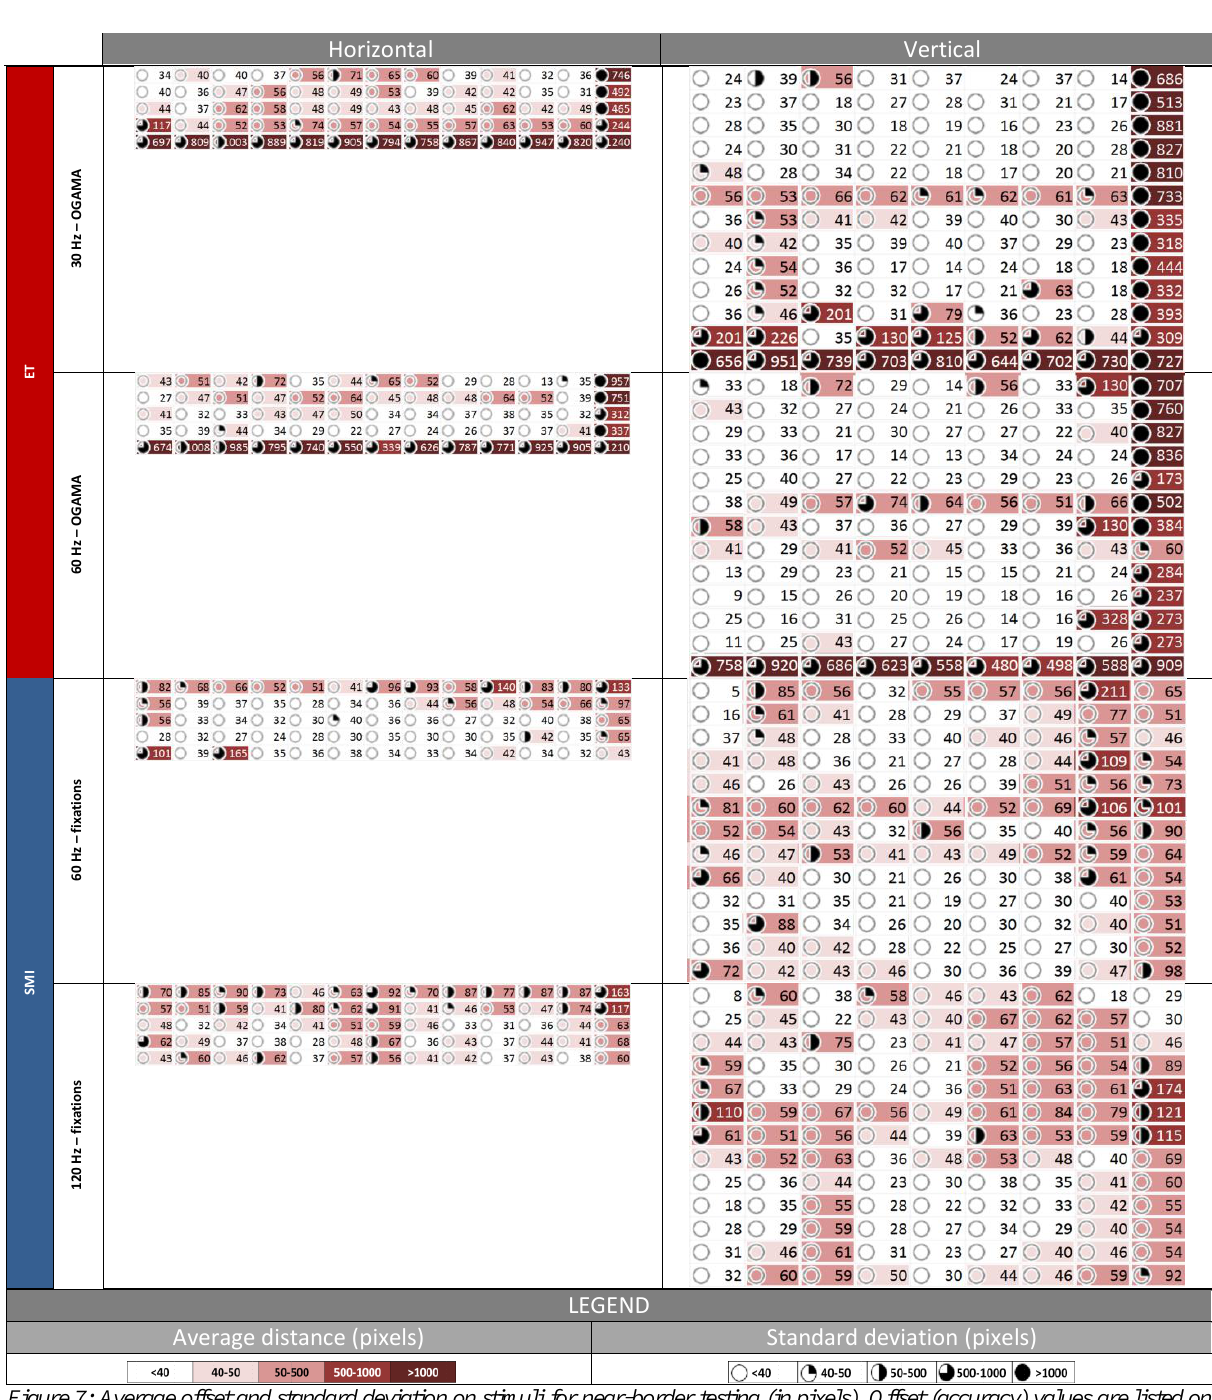
Figure 7: Average offset and standard deviation on stimuli for near-border testing (in pixels). Offset (accuracy) values are listed on the approximate corresponding positon on the screen in a tabular layout. The color of the cells corresponds to the offset value, categorized in five steps. The standard deviation (precision) is visualized using a pie chart that is added to the corresponding cell, also using the same five